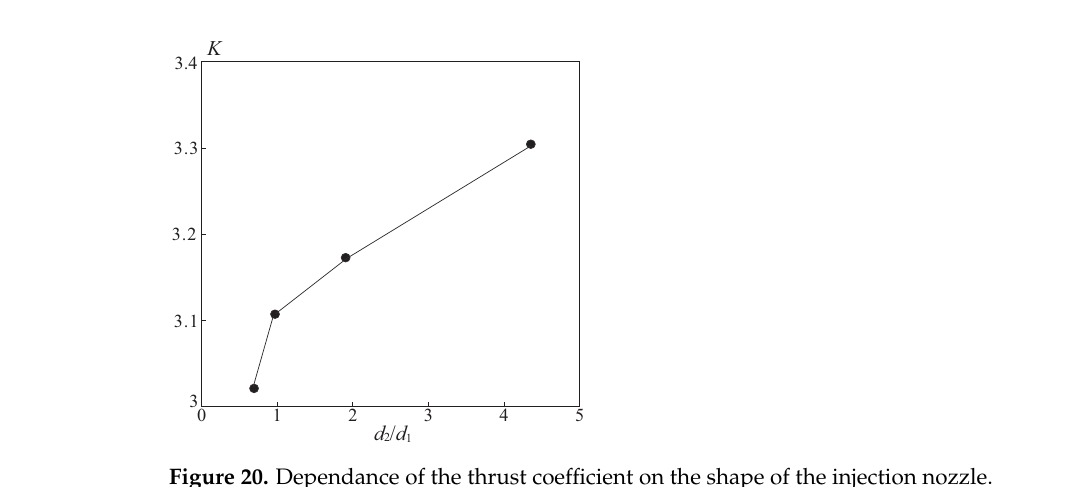
Figure 20. Dependance of the thrust coefficient on the shape of the injection nozzle. Table 3. Thrust coefficient as a function of the shape of the injection nozzle. Shape of Outlet Section Ratio of Axis Thrust Coefficient Ellipse 0.88 3.05 Circle 1.0 3.12 Ellipse 2.0 3.18 Ellipse 4.6